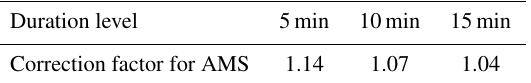
Table 3. Correction factors for annual maximum series (AMS) of short duration according to the DWA-531 (DWA, 2012).